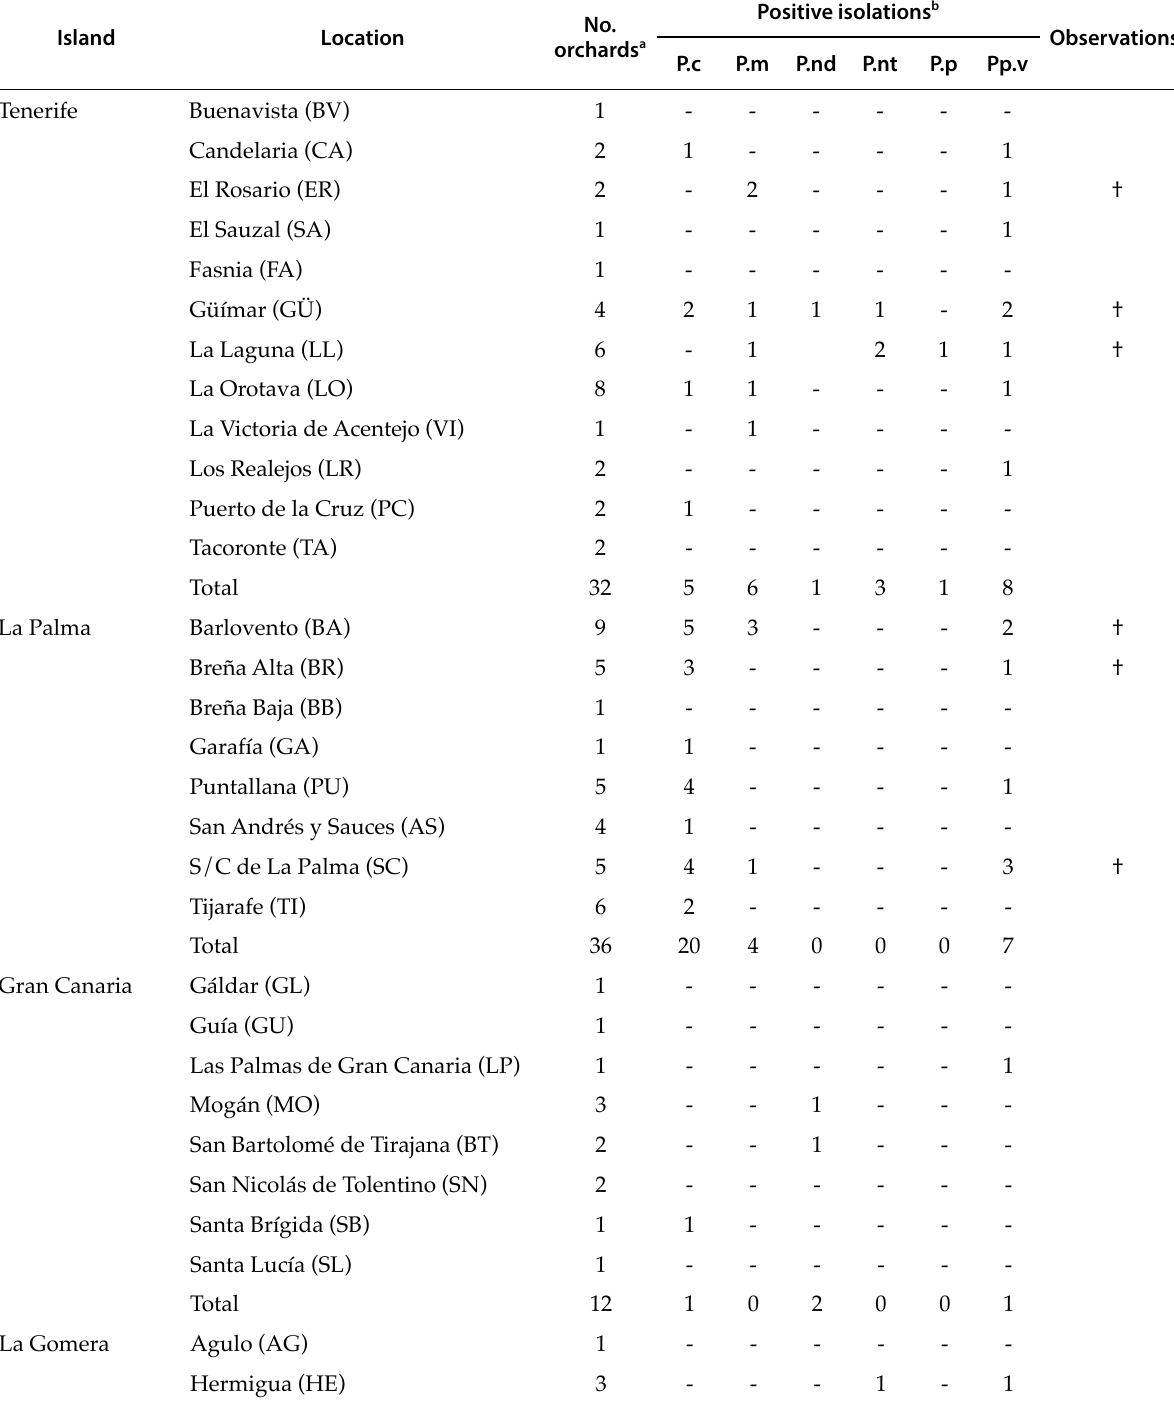
Table 2. Occurrence of Phytophthora spp. and Phytopythium vexans in avocado orchards of the Canary Islands.